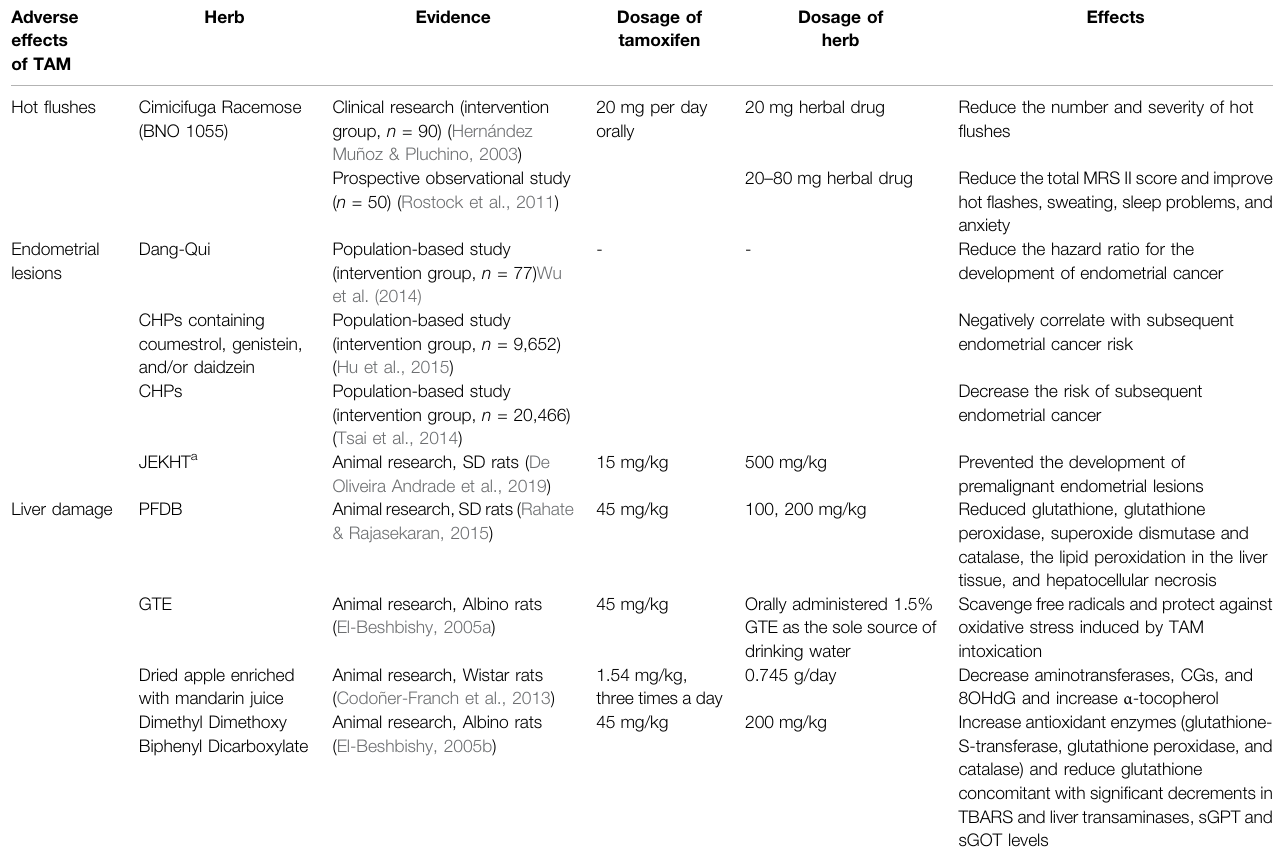
TABLE 5 | Reported evidence of reducing toxic and side effects of tamoxifen.